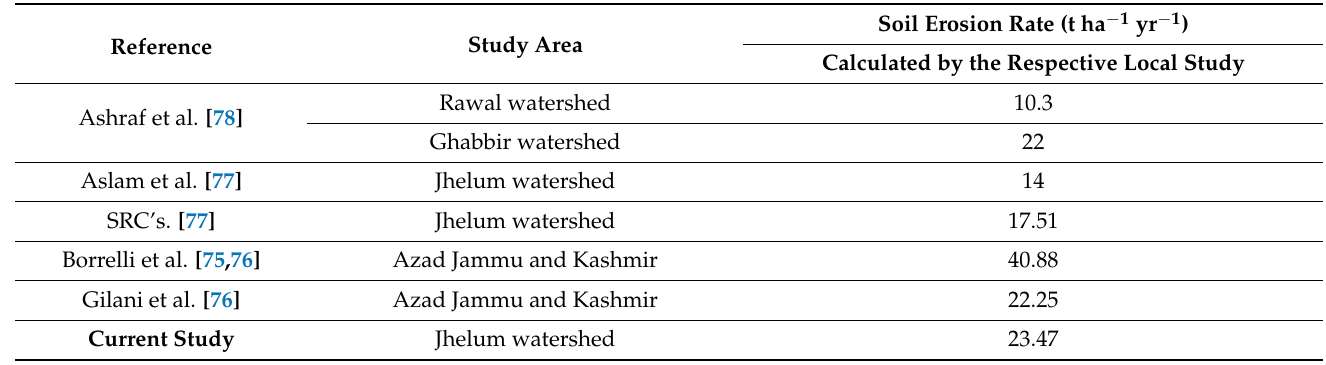
Table 4. Comparing soil erosion estimates in neighboring areas with similar topography using both global and local